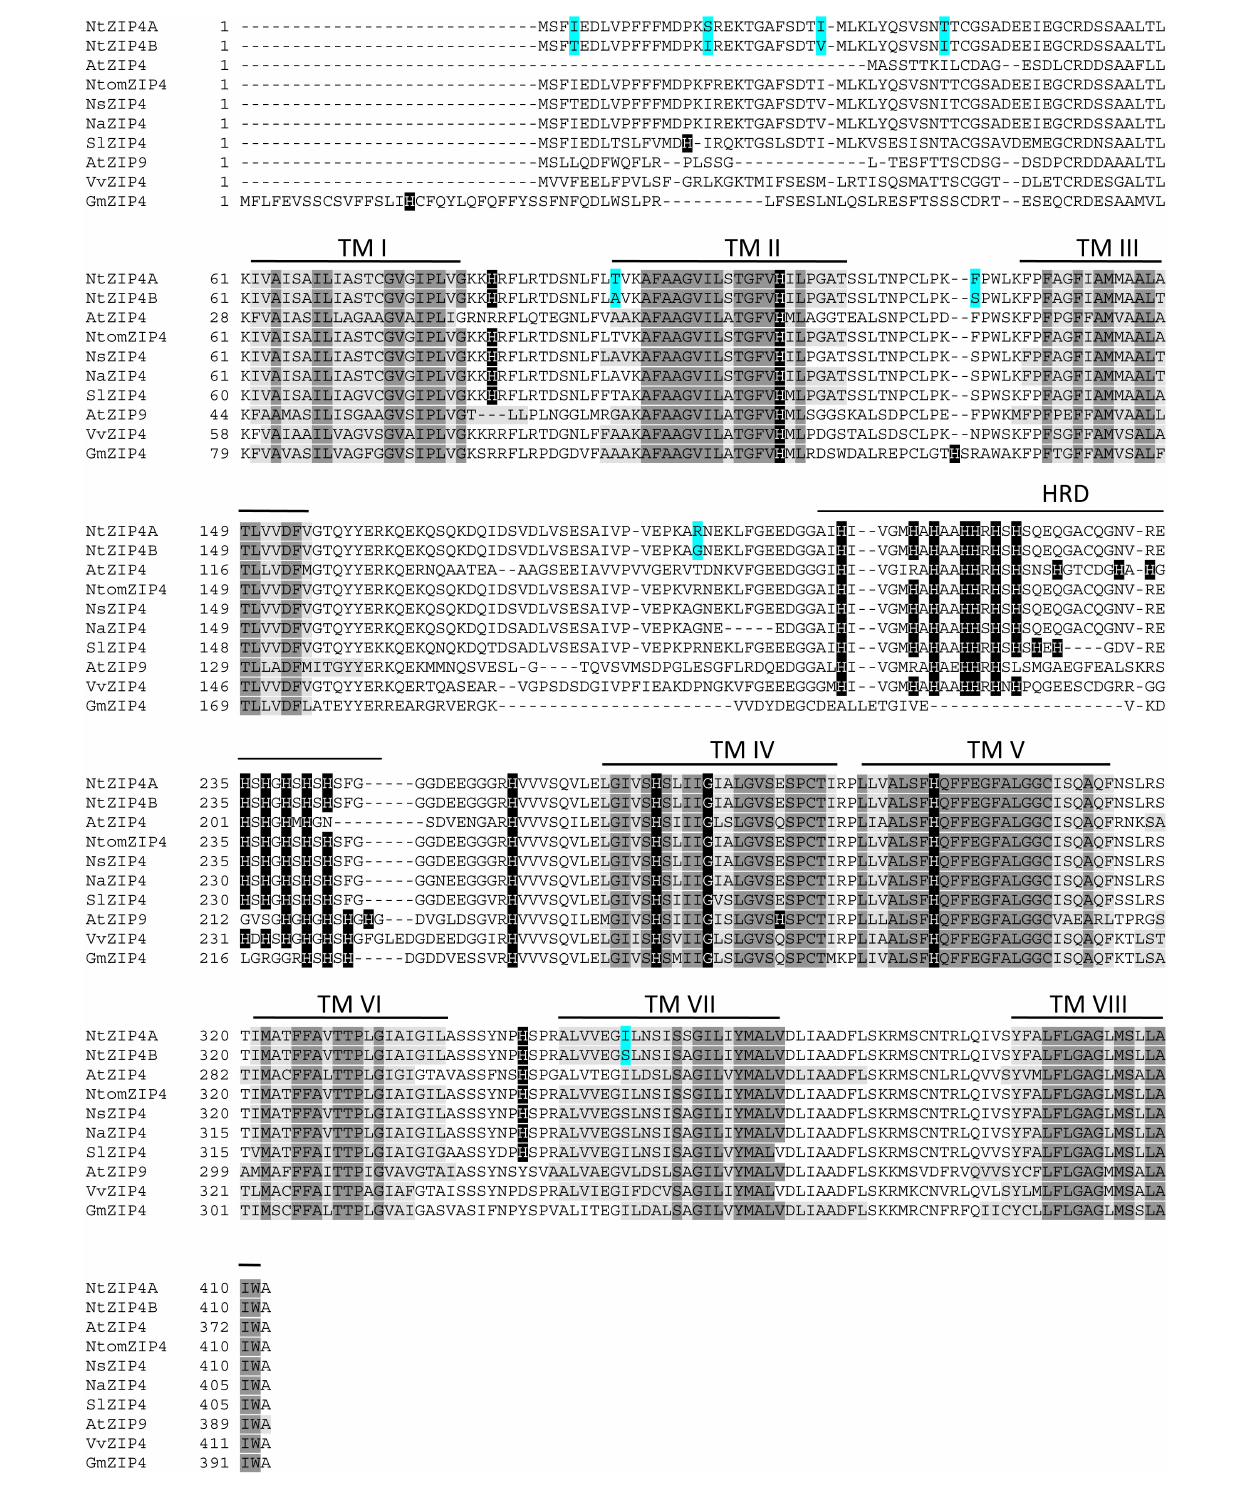
FIGURE 2 | Amino acid alignment of predicted ZIP4 proteins from different species. Sequences were aligned using ClustalW. The prediction of membrane-spanning regions was performed using TMpred program (https://embnet.vital-it.ch/software/TMPRED_form.html), and indicated as lines above the sequences, and numbered I–VIII, respectively. Sequences of the transmembrane domains are marked with light gray; identical amino acids with dark gray; histidines in black. HRD, Histidine Rich Domain within the variable cytosolic region. Dashes indicate gaps.